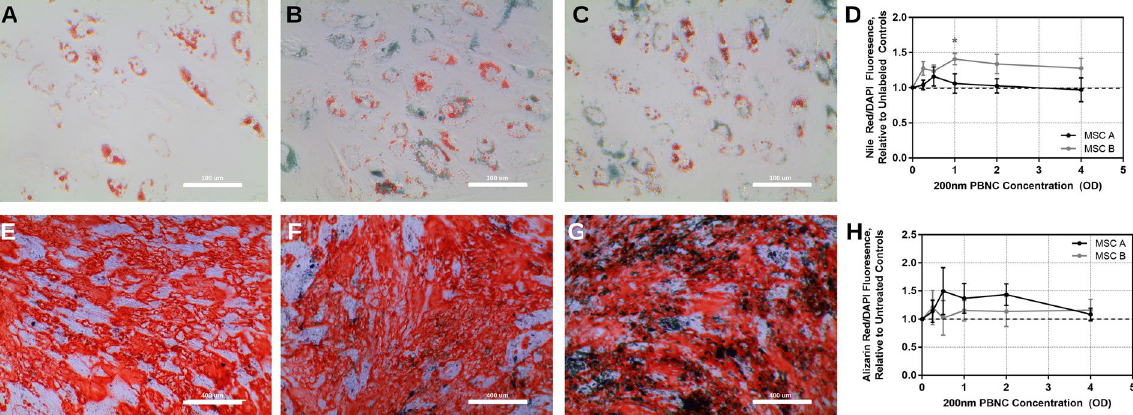
Figure 7. Effect of 200 nm PBNCs on MSC Differentiation. (A–D) Oil Red O staining for lipids 7 days after adipogenesis treatment in (A) unlabeled MSCs, (B) 1 OD 200 nm PBNC-MSCs, and (C) 4 OD 200 nm PBNC- MSCs. (D) Quantification of ratio of fluorescent Nile Red (lipids) to DAPI (nuclei) signal relative to untreated controls for 2 stem cell lines (n = 3 technical replicates for each concentration). (E–H) Alizarin Red O staining for free calcium after 21 day osteogenesis treatment in (E) unlabeled MSCs, (F) 1 OD 200 nm PBNC-MSCs, and (G) 4 OD 200 nm PBNC-MSCs. (H) Ratios of fluorescent Alizarin Red (free calcium) to DAPI (nuclei) signal relative to untreated controls for 2 stem cells (n = 3 technical replicates for each concentration). Error bars denote standard deviations. Asterisks denote significant difference (p < 0.05) compared to unlabeled controls as determined by ANOVA, with Dunnett’s post hoc